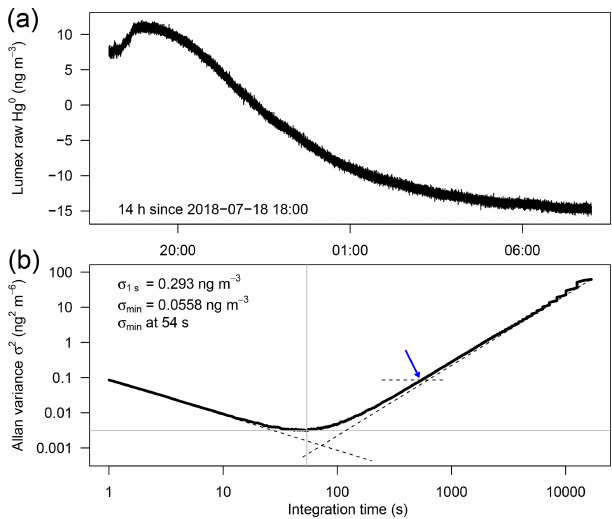
Figure 3. Allan variance plot using 14h of continuous mea- surements in the laboratory (zero-flux experiment), starting on 18 July 2018 at 18:00. Panel (a) shows the raw time series, and panel (b) shows the Allan variance as a function of integration